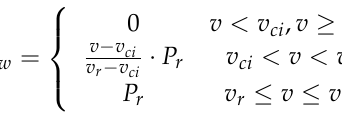
Figure 15. The simulation of power balance in Scenario F . ( a ) Power at PCC; and ( b ) The variation of power imbalance. power